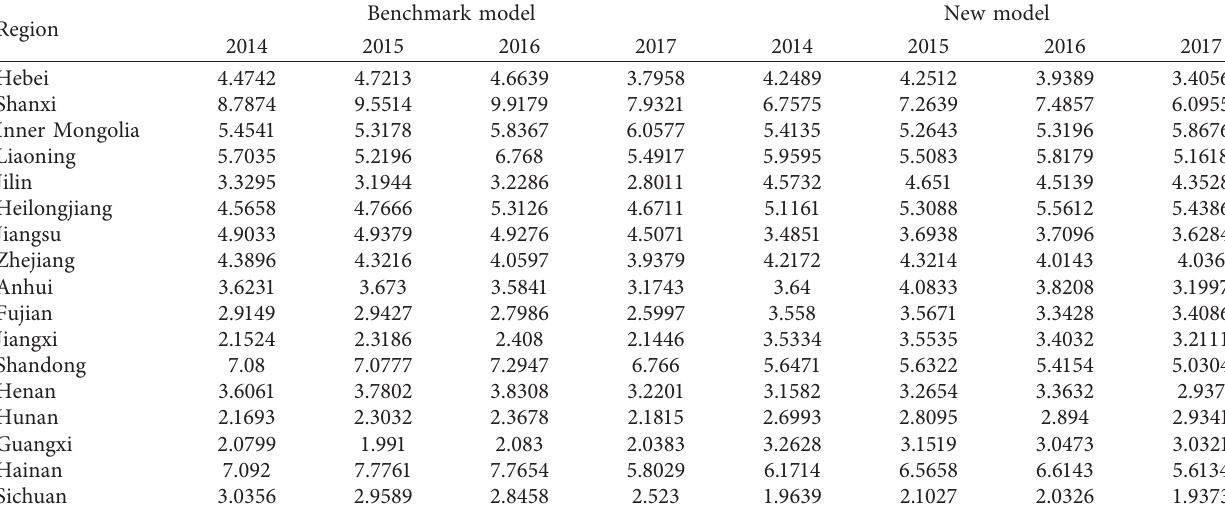
Table 9: Test quotas of nonpilot